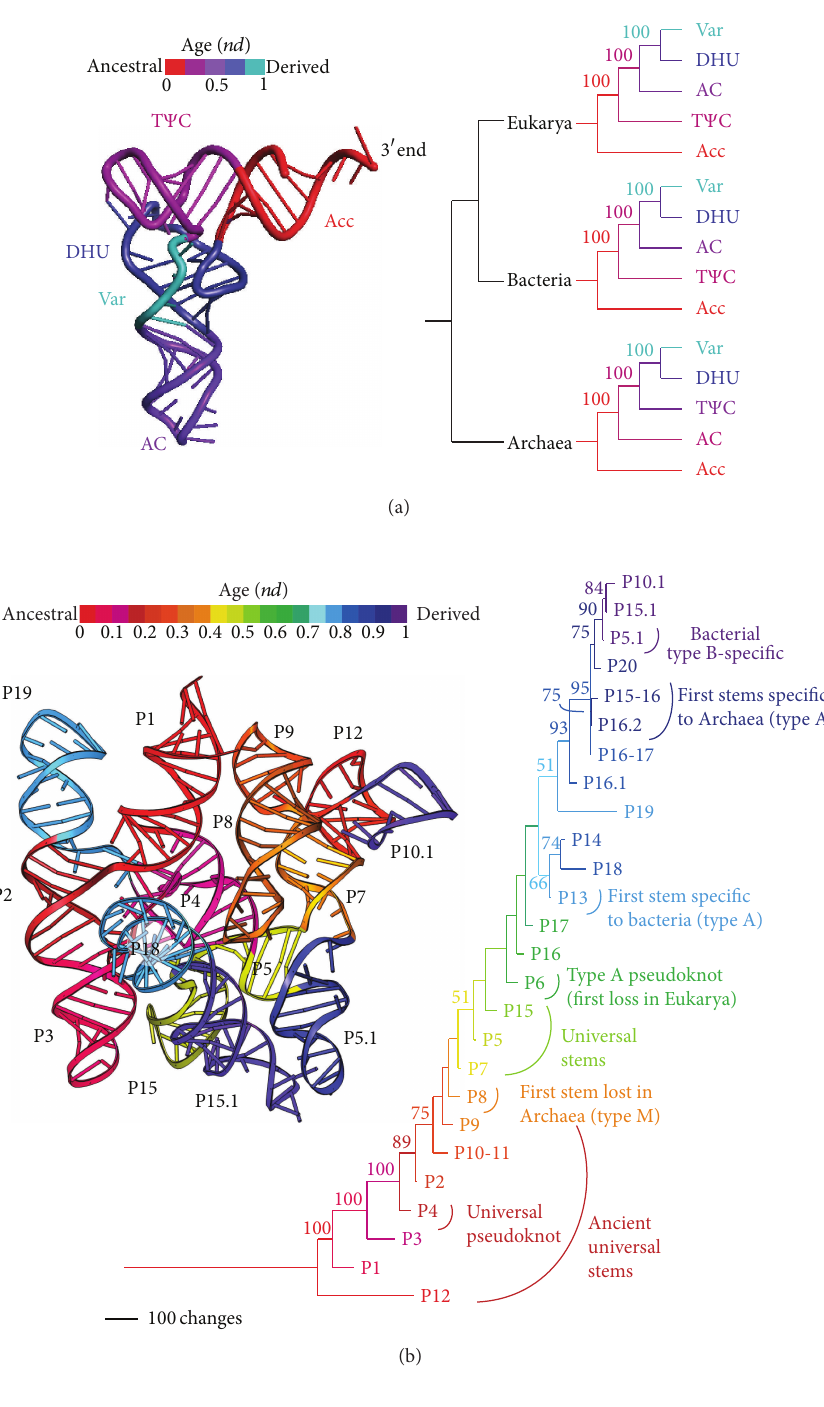
Figure 9: The history of accretion of tRNA and RNase P RNA substructures reveals the early evolutionary appearance of Archaea. (a) Rooted trees of tRNA arm substructures reveal the early appearance of the acceptor arm (Acc) followed by the anticodon arm (AC) in Archaea or the pseudouridine (T Ψ C) arm in both Bacteria and Eukarya (from [108]). The result confirms the sister group relationship of Bacteria and Eukarya. (b) Trees of molecular substructures of RNase P RNAs were reconstructed from characters describing the geometry of their structures (from [135]). Branches and corresponding substructures in a 3D atomic model are colored according to the age of each substructure ( nd , node distance). Note the early loss of stem P8 in Archaea immediately after the evolutionary assembly of the universal functional core of the